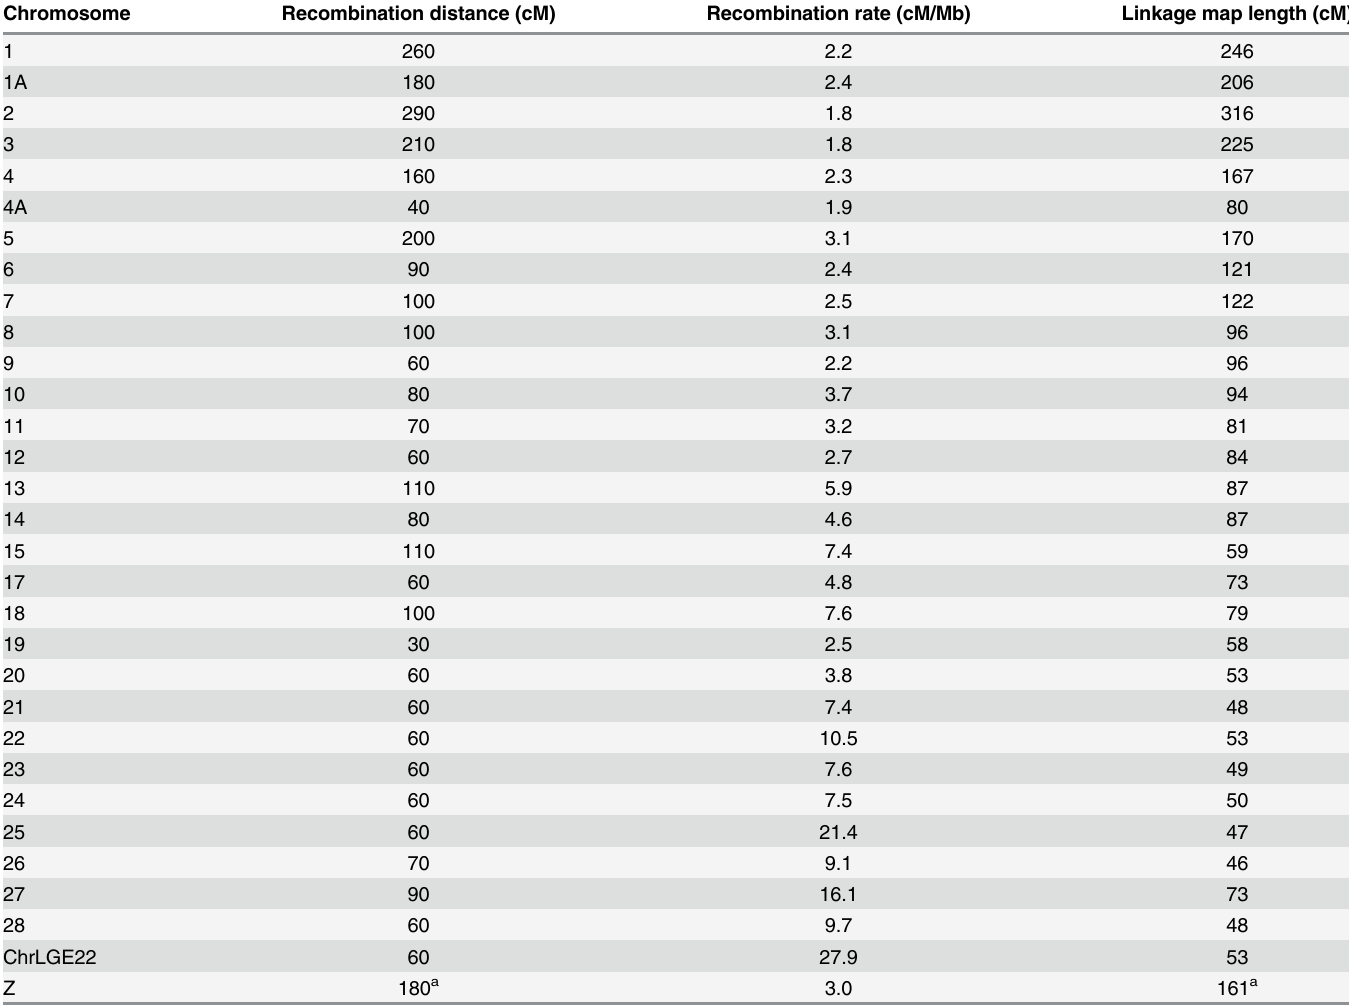
Table 1. Recombination distance per chromosome calculated from the number of observed recombination events in the pedigree and linkage map length from the corresponding chromosomes. Linkage map data are from Kawakami et al. [55] and refer to the sex-average best-order map length per